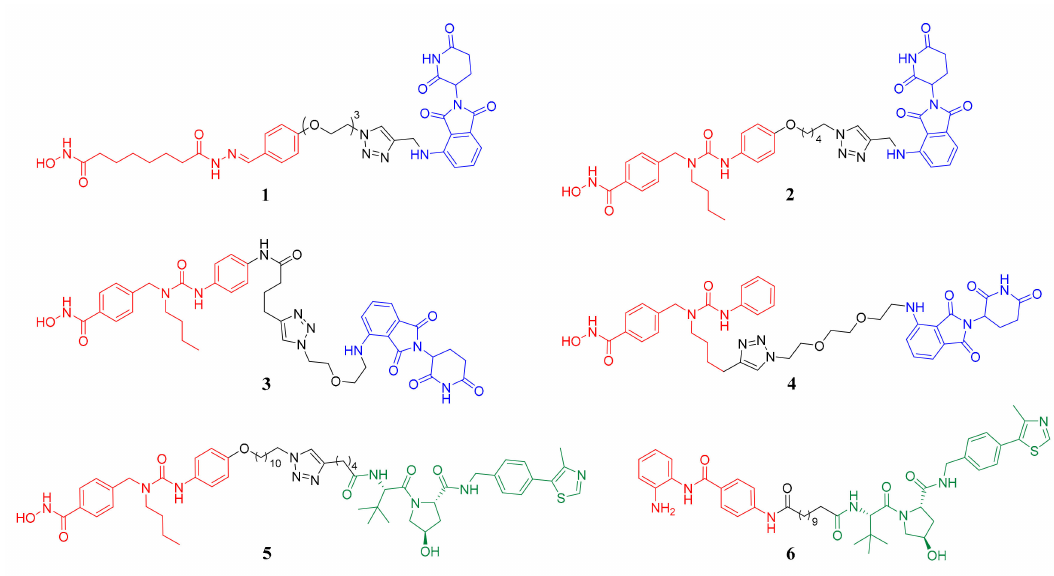
Figure 1. The structures of reported histone deacetylase (HDAC) degraders. The HDAC binding parts are in red, the linker parts are in black and the cereblon (CRBN) and von Hippel-Lindau (VHL) ligands are in blue and green,